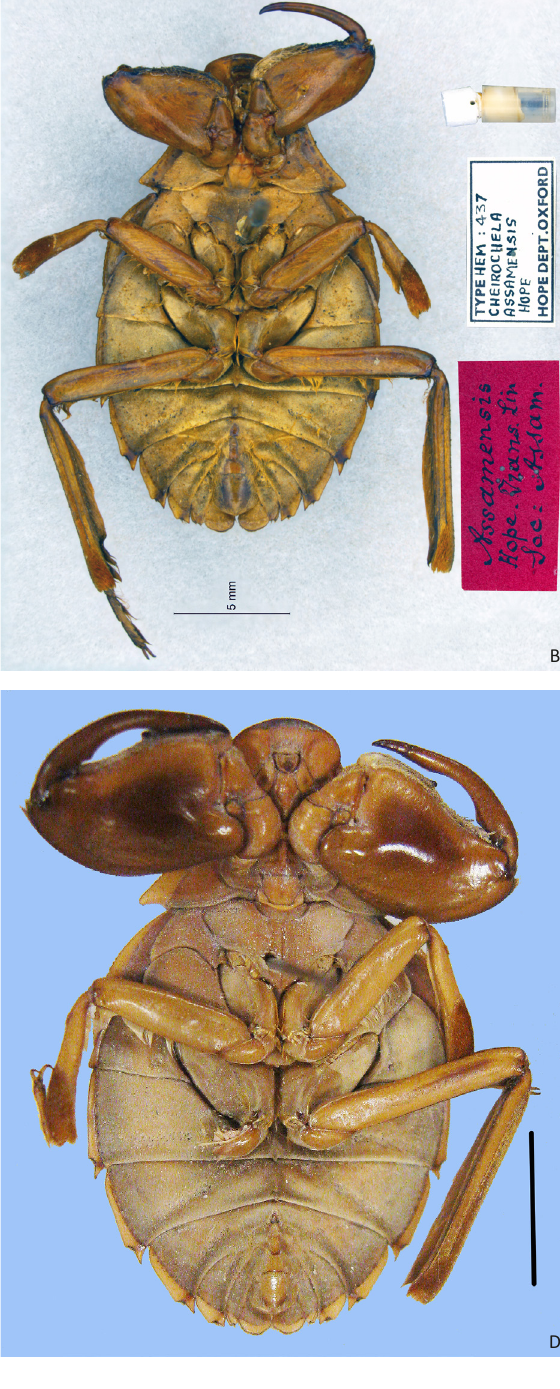
Image 2. Cheirochela spp. A - C. assamensis type - dorsal view; B - C. assmensis type - ventral view; C - C. thailandana paratype - dorsal view; D - C. thailandana paratype - ventral view (scale for C,D -